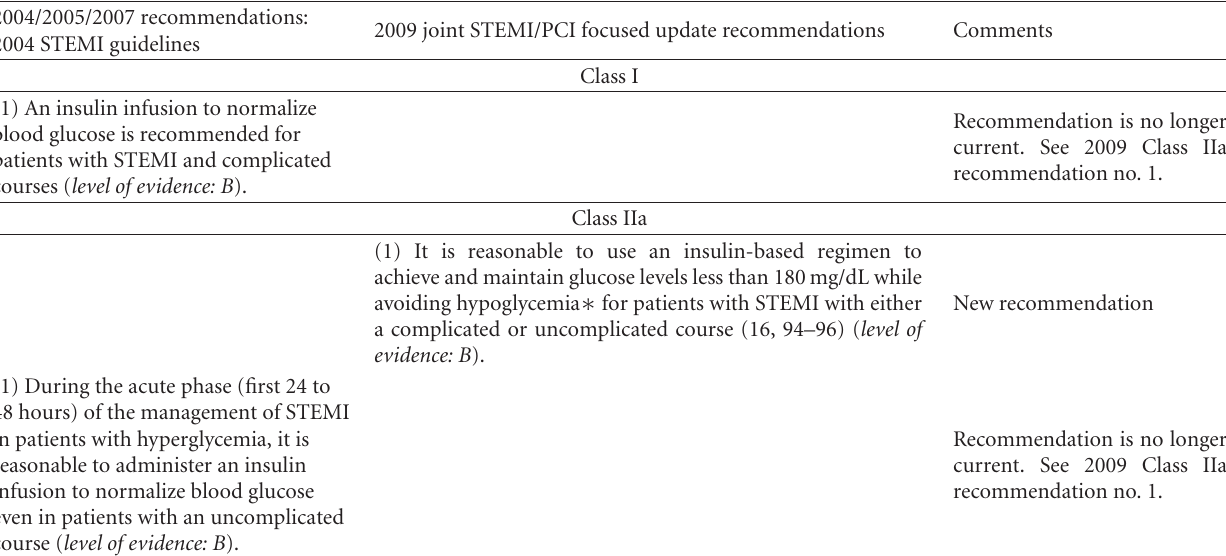
Table 2: Recommendations for intensive glucose control in